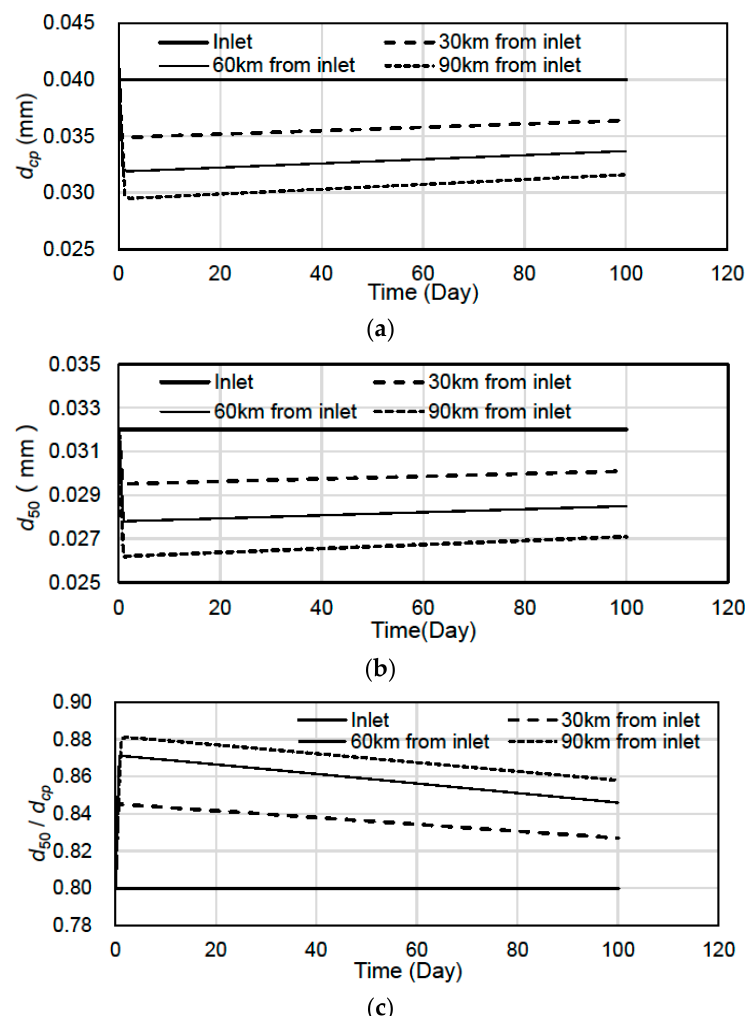
Figure 2. Temporal variation in the suspended-load under deposition conditions. ( a ) d cp ; ( b ) d 50 ; and ( c ) d 50 / d cp